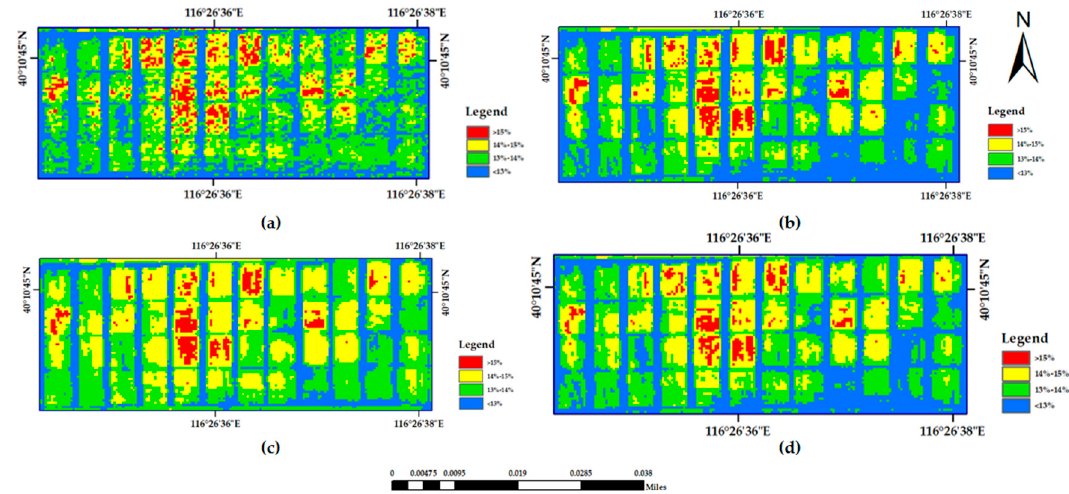
Figure10. UAVdatainversionofthegrainproteincontent. ( a ) GPC LNC spatialdistributionmap. ( b ) GPC Figure 10. UAV data inversion of the grain protein content. ( a ) 𝐺𝑃𝐶 (cid:3013)(cid:3015)(cid:3004) spatial distribution map. ( b ) 𝐺𝑃𝐶 (cid:3013)(cid:3015)(cid:3002) spatial distribution map. ( c ) 𝐺𝑃𝐶 (cid:3017)(cid:3015)(cid:3004) spatial distribution map. ( d ) 𝐺𝑃𝐶 (cid:3017)(cid:3015)(cid:3002) spatial distribution map .